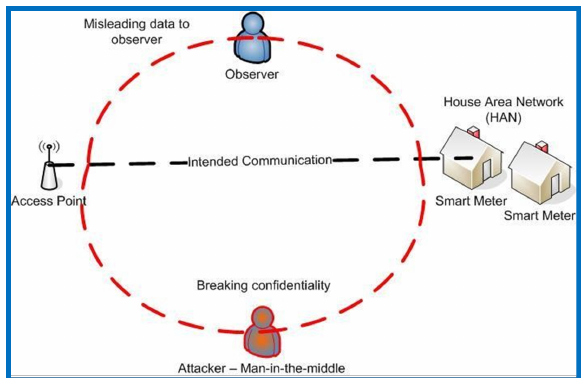
Figure 6. How a man-in-the-middle attack intercepted messages passing via the smart city communi- cation